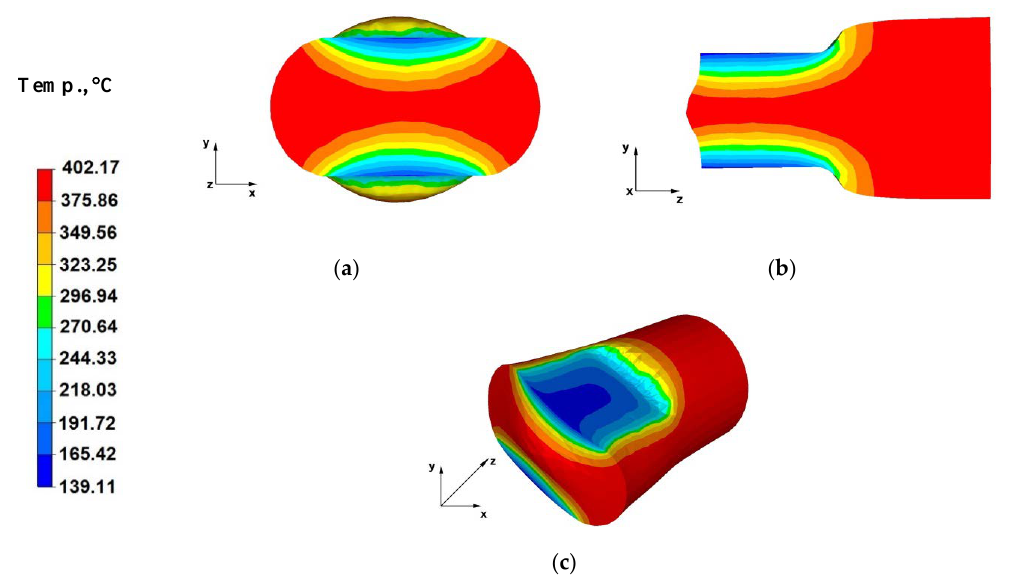
Figure 7. ( a ) Temperature distribution over the cross-section of an AZ91 alloy forging deformed within the first pass, with a relative reduction of 40%, in flat dies; ( b ) Temperature distribution over the longitudinal section of an AZ91 alloy forging deformed within the first pass, with a relative reduction of 40%, in flat dies; ( c ) Axonometric view of the temperature distribution over the surface of an AZ91 alloy forging deformed within the first forging pass, with a relative reduction of 40%, in flat dies.